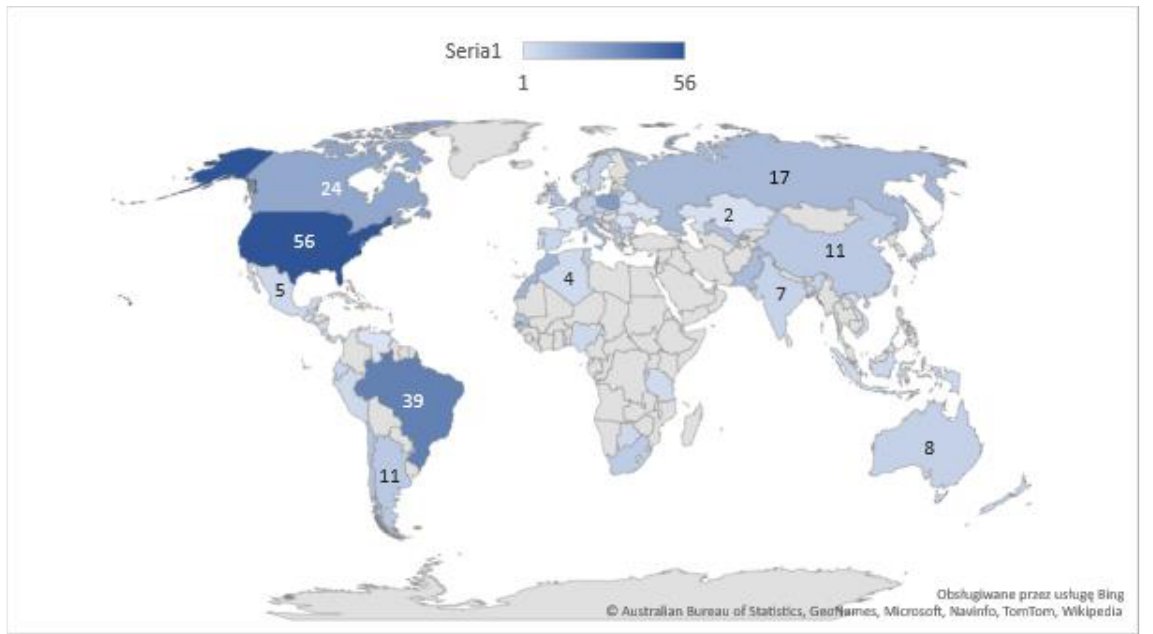
Figure 1. Geographical distribution of respondents by the country where the programme was administered.